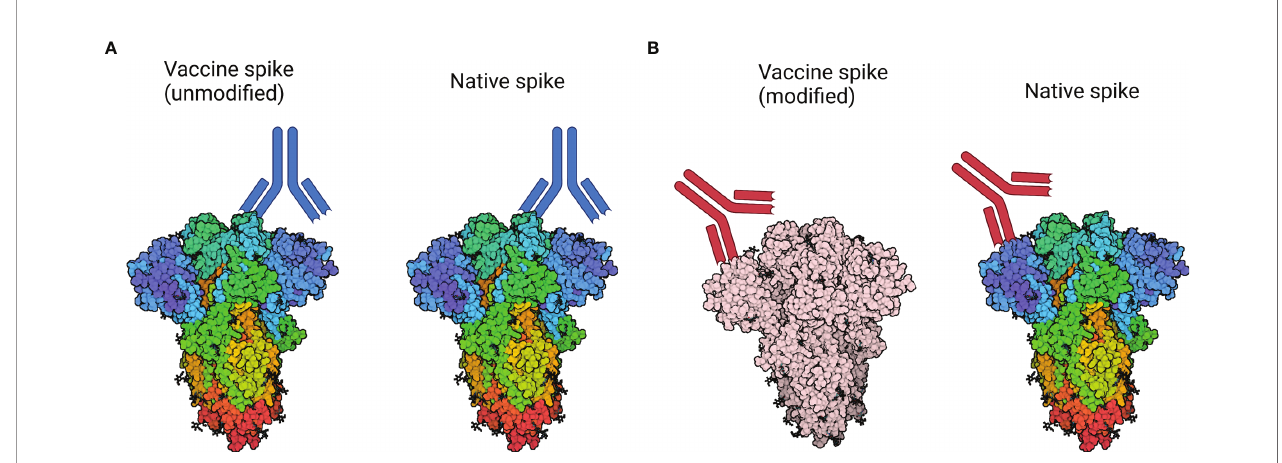
FIGURE 3 | How modi fi cation of the spike protein could impact neutralising activity. (A) Native spike: Antibodies are generated against a neutralising epitope on the vaccine-derived spike protein, which closely represents the neutralising epitope found on circulating virus. As a result, neutralising activity against the vaccine-derived spike corresponds to neutralisation of circulating virus. (B) Modi fi ed spike: Antibody responses may be generated against a modi fi ed epitope, which no longer represents a neutralising epitope on circulating virus. As a result, antibodies produced in response to native spike may be sub-neutralising or non-neutralising and may contribute to VAED. Spike protein structure accessed through Protein Data Bank, PBD entry 6VXX (120). Created with